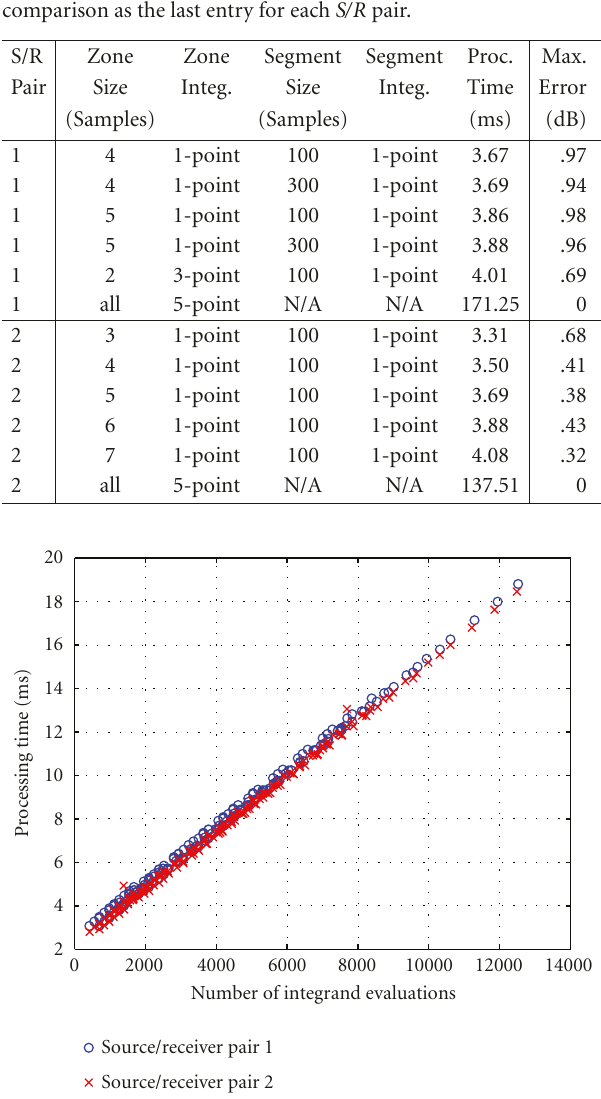
Figure 6: Relationship between the processing time and number of evaluations of the di ff raction integrand. Processing times are the same as those in Figure 5.